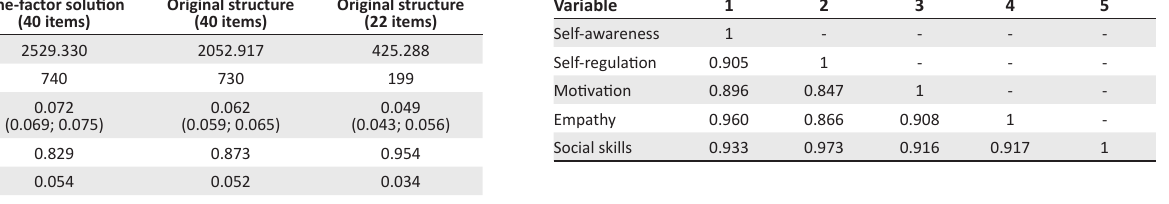
TABLE 1: Goodness-of-fit statistics (Sample 1, n = 470). Model